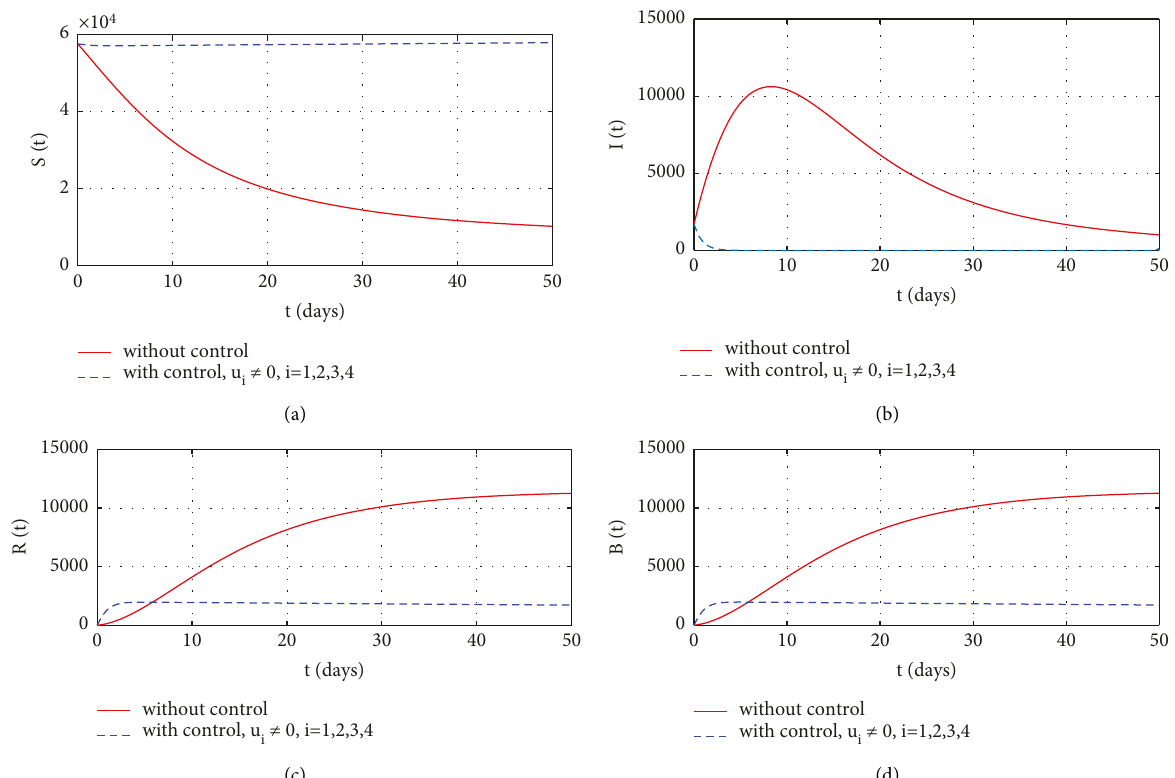
Figure 9: Simulations of effects of applying all control measures on cholera infection